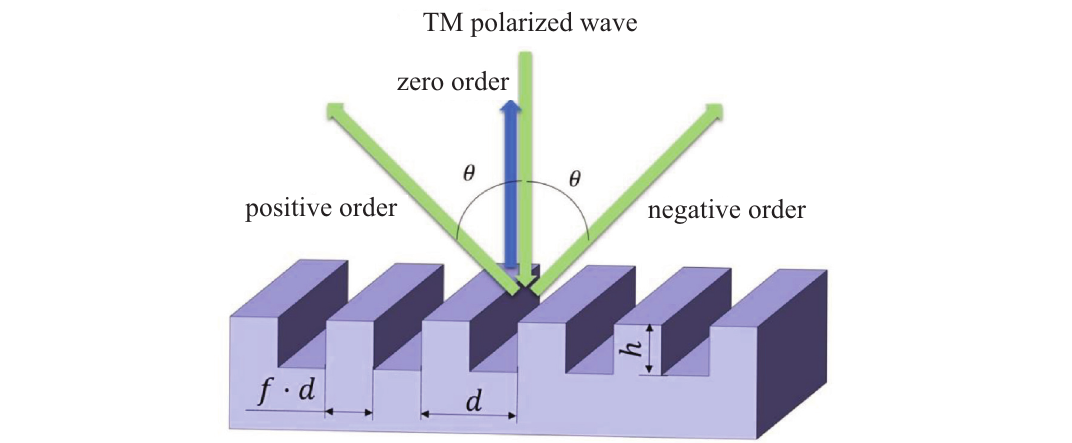
Fig. 2. Geometry of the rectangular metallic grating